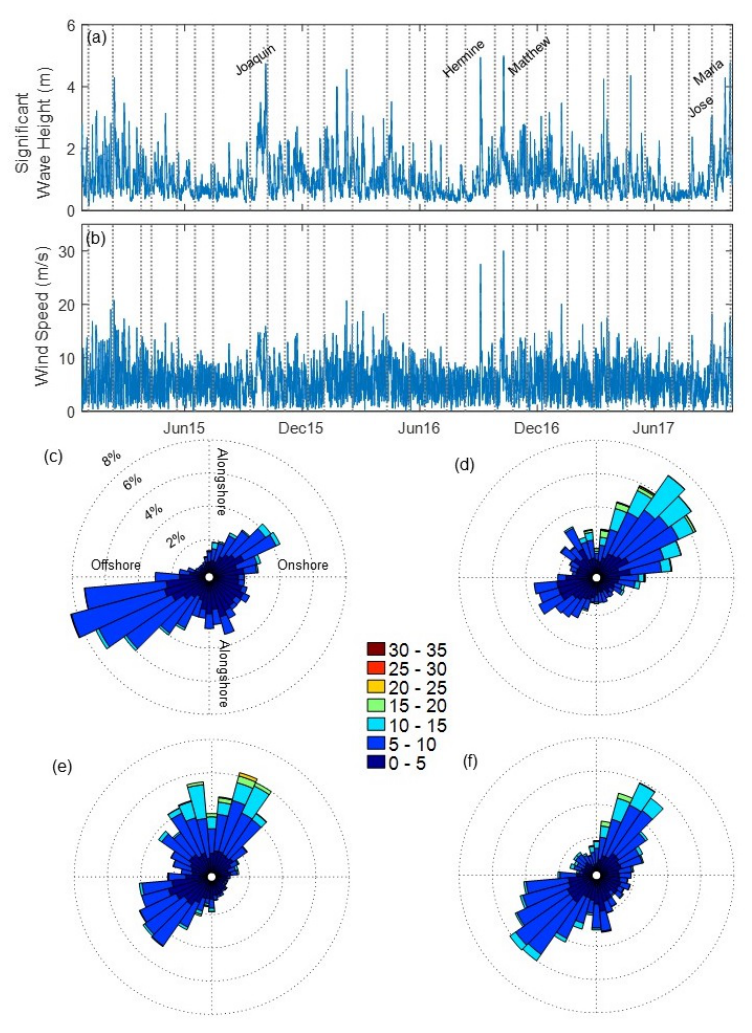
Figure 3. Significant wave height with vertical dashed lines indicating ( a ) survey dates and ( b ) wind speed during the study period. Shore-normal rotated wind roses for the ( c ) summer, ( d ) fall, ( e ) winter, and ( f ) spring during the study period, with colors indicating wind velocity (m/s) and dotted circles indicating percent